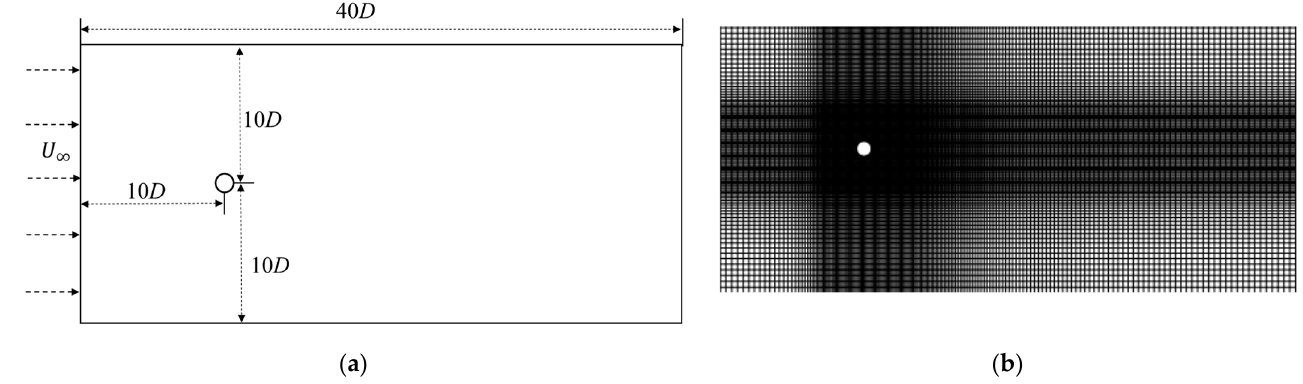
Figure 2. Sketch of the computational domain ( a ) and the mesh ( b ) for flow past a circular cylinder. Two steady and an unsteady flow past a stationary cylinder are simulated, in which the Reynolds numbers are 20, 40 and 100. The Reynolds number is defined as: